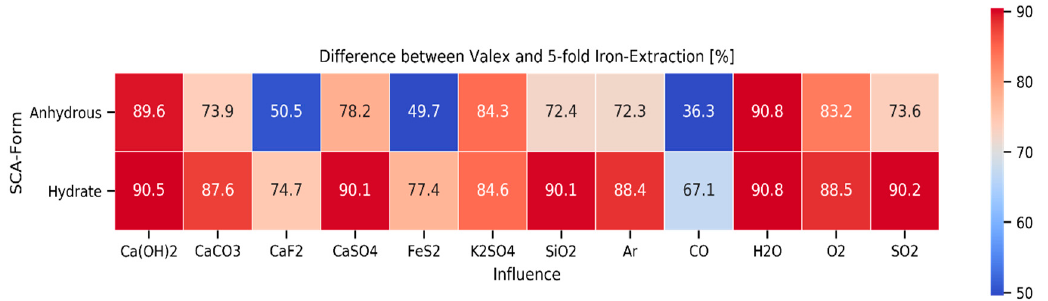
Figure 8. Difference between valex and 5 ‐ fold iron extraction for various atmospheres and secondary compounds in com ‐ bination with anhydrous or hydrated SCAs, mean values for temperatures, pressure of 1 atm, and stoichiometry of 1 .